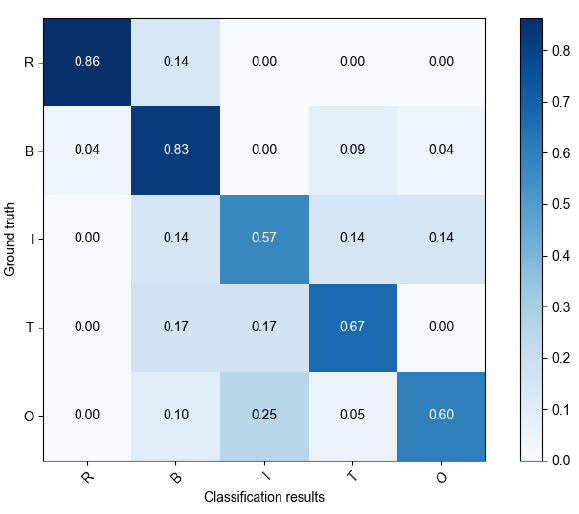
Figure 8. Normalized confusion matrix of supervised classification (RF in this case)